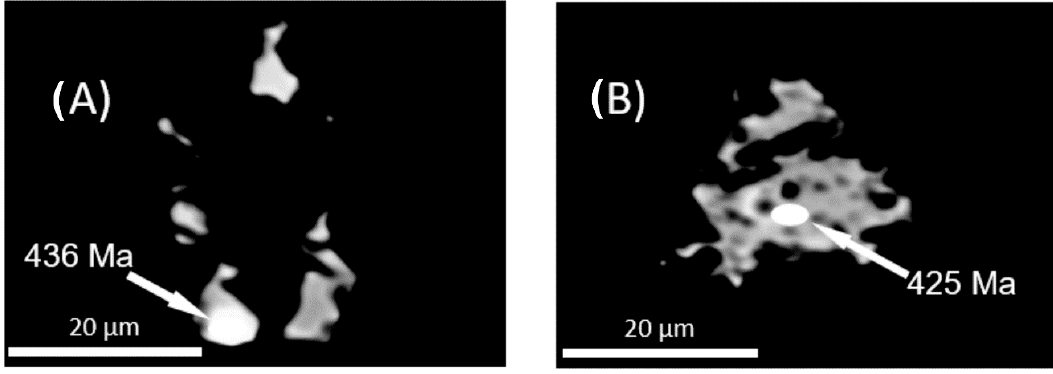
Figure 7. A close-up BSE image of a monazite grain (above, white phase) and EDS analysis (below). Sample RIC 3.